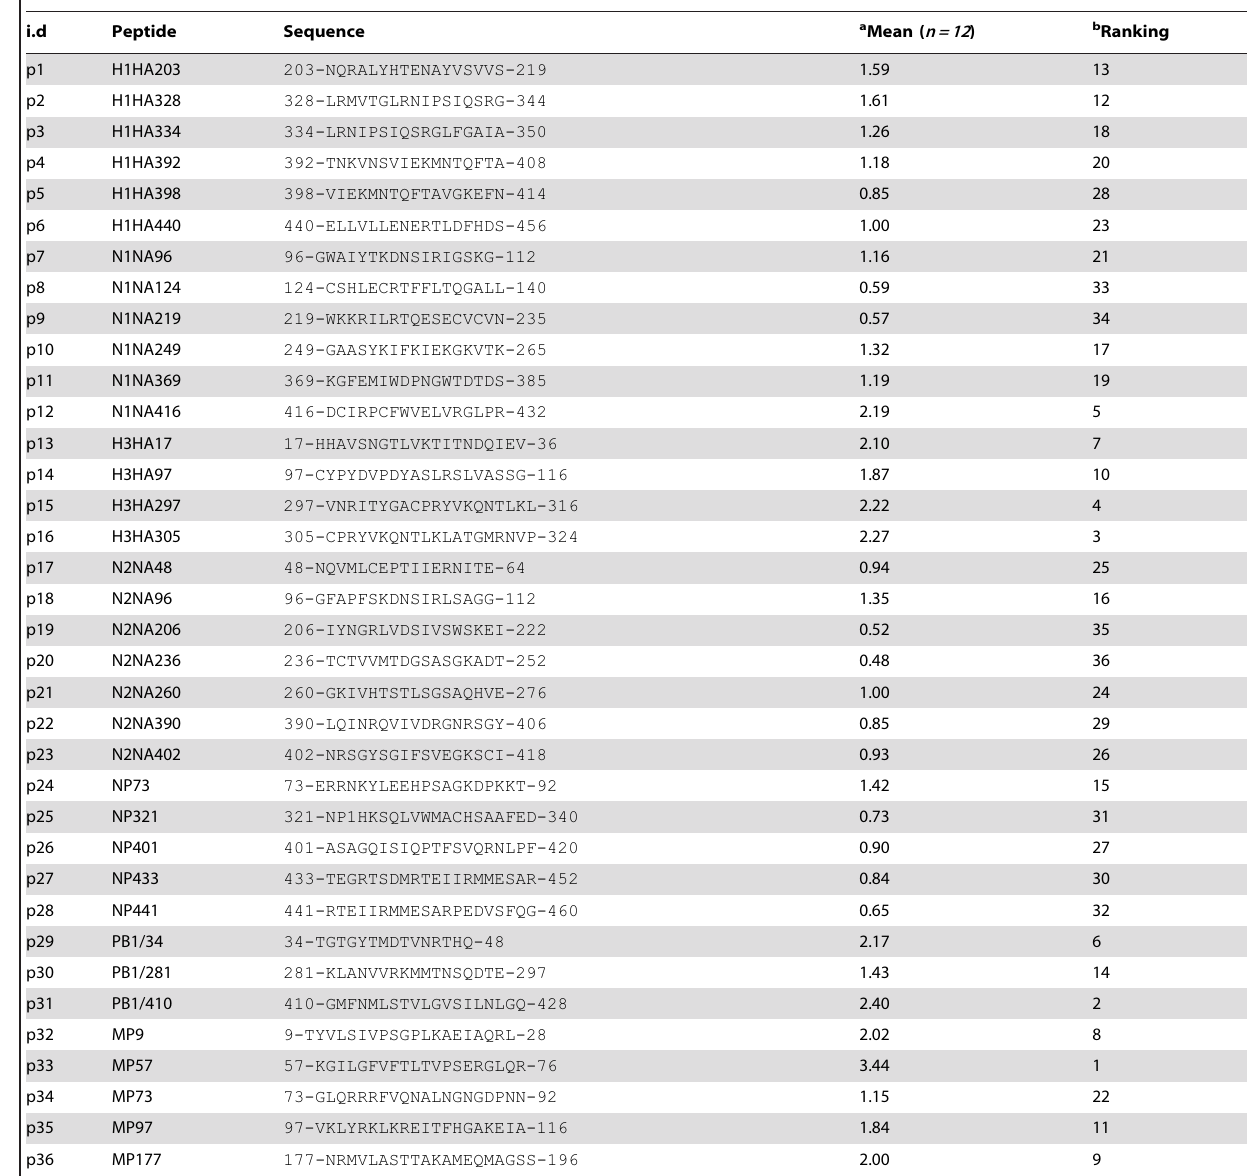
Table 1. Summary for Influenza A specific T cell